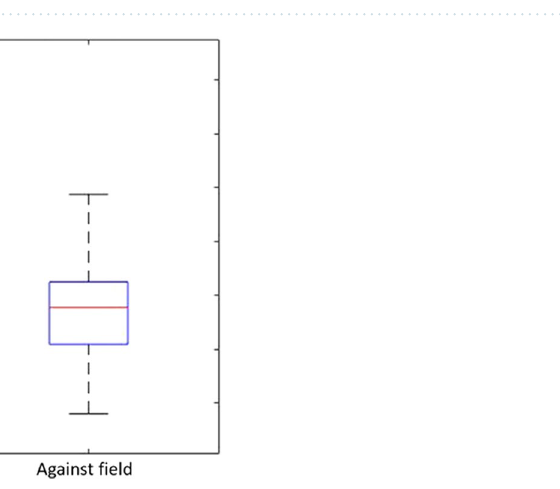
Figure 5. Relationship between the location of the leading centre and the travelling direction of droplets. ( A – D ) Distributions of the leading center locations (marked with x) within a schematic BZ droplet at different external electric field strengths. ( E – H ) Circular histogram of the travelling angles of chemically driven translation motion of droplet. The electric field was applied with the positive electrode on the left, and the negative electrode on the right. The applied voltages across the petri dish are shown in the labels on the top row. Data points were collected from 163 droplets.